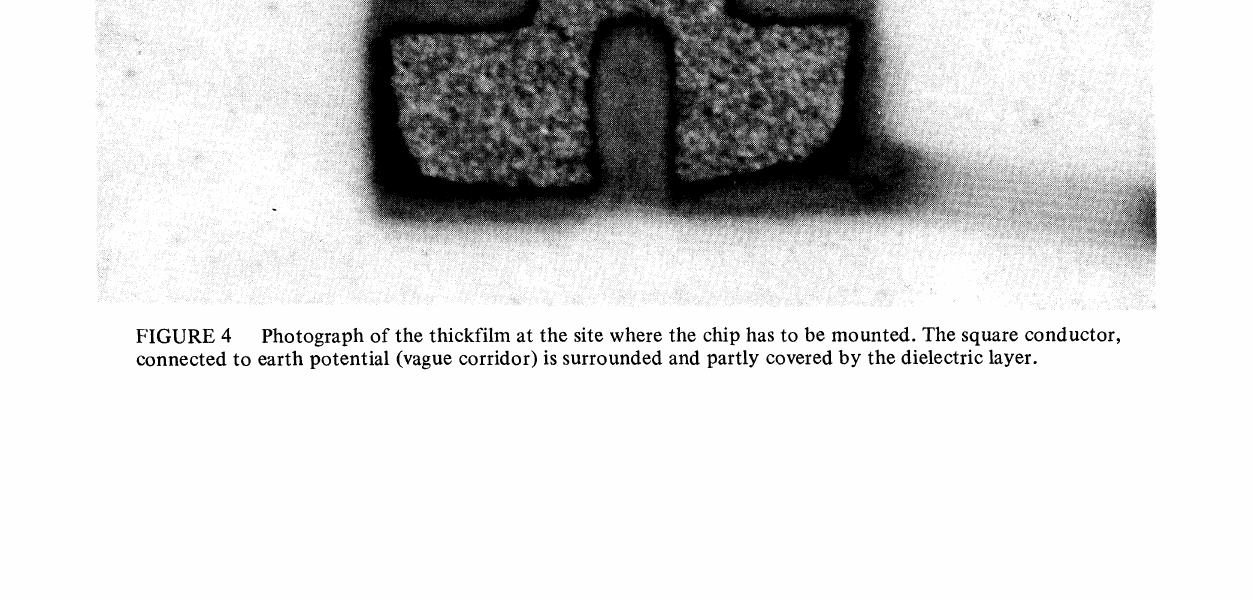
FIGURE 4 Photograph of the thickfilm at the site where the chip has to be mounted. The square conductor, connected to earth potential (vague corridor) is surrounded and partly covered by the dielectric